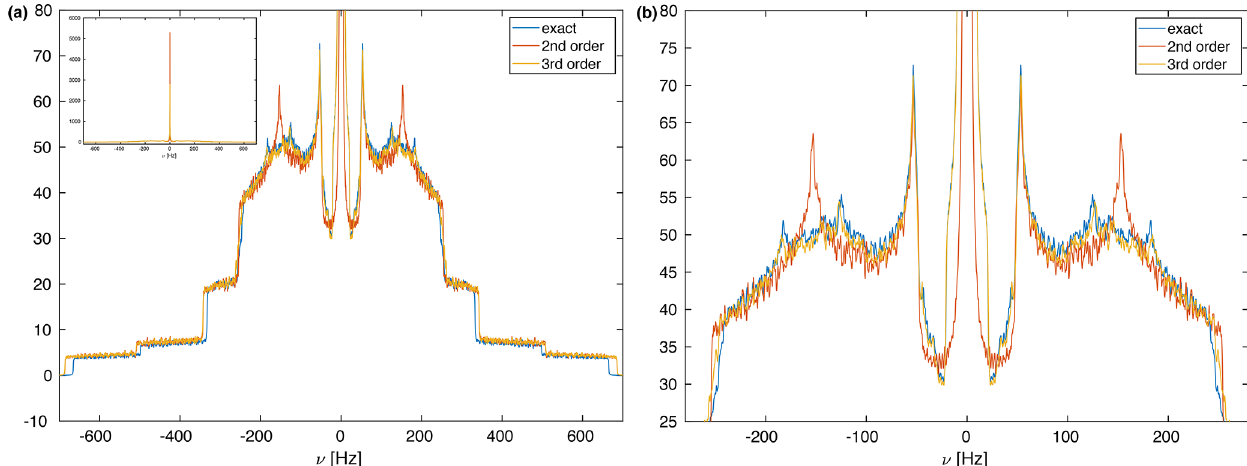
Figure 2. (a) Calculated MAS spectra at a spinning frequency of 50kHz using different approximations of the effective Hamiltonian. All spectra were processed with an exponential line broadening of 1Hz. The central very narrow peak is cut for a better display of the spectrum, but the complete spectrum is shown as an inset in the upper left corner. The spin-system parameters are δ 12 / (2 π ) = − 44826Hz, δ 13 / (2 π ) = − 8898Hz, δ 23 / (2 π ) = − 5750Hz, θ 13 = 90 ◦ , θ 23 = 120 ◦ . The spectral window was set to 2000Hz with 20000 data points leading to a digital resolution of 0.1Hz. One hundred thousand powder points were sampled according to the ZCW scheme (Cheng et al., 1973). (b) Expanded central region of the spectrum in panel (a) . Here one can clearly see the differences between the second-order and third-order approximations that are very close to the exact spectrum.